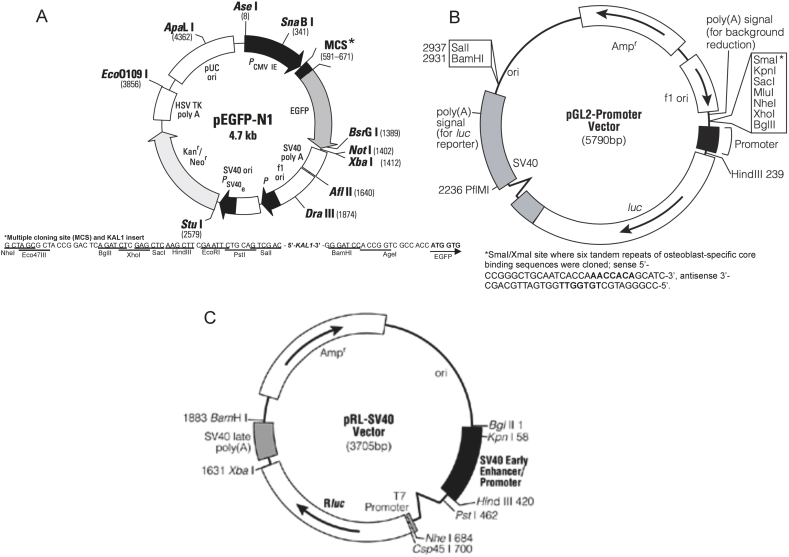
Schematic representation of expression and reporter vectors used for novel application of our luciferase reporter assay for functional assessment of KAL1 variants in vitro. A, Full length human KAL1 (NM_000216) had previously been cloned into the SalI (5′) and BamHI (3′) restriction sites of the pEGFP-N1 expression vector (Clontech) (Hu et al., 2009). In the presence of the mutated KAL1 stop codon, the encoded protein anosmin-1 is conjugated to GFP at the C-terminal. Empty pEGFP-N1 vector which expresses GFP alone was used as control. B, The p6xOSE2-Luc reporter vector was produced as previously described (Kim et al., 2003, Park et al., 2010). Six identical osteoblast-specific core binding sequences (bold) (OSE2) of the FGF responsive osteocalcin promoter were synthesised with XmaI overhangs at each 5′ end of the oligonucleotides and ligated. Multimers were then cloned into the SmaI/XmaI restriction site of the pGL2-promoter reporter vector (Promega). C, Luciferase activity stimulated by the KAL1 expression vector via the p6xOSE2-Luc reporter vector was normalised to the constitutively active Renilla luciferase reporter pRL-SV40 (Promega).